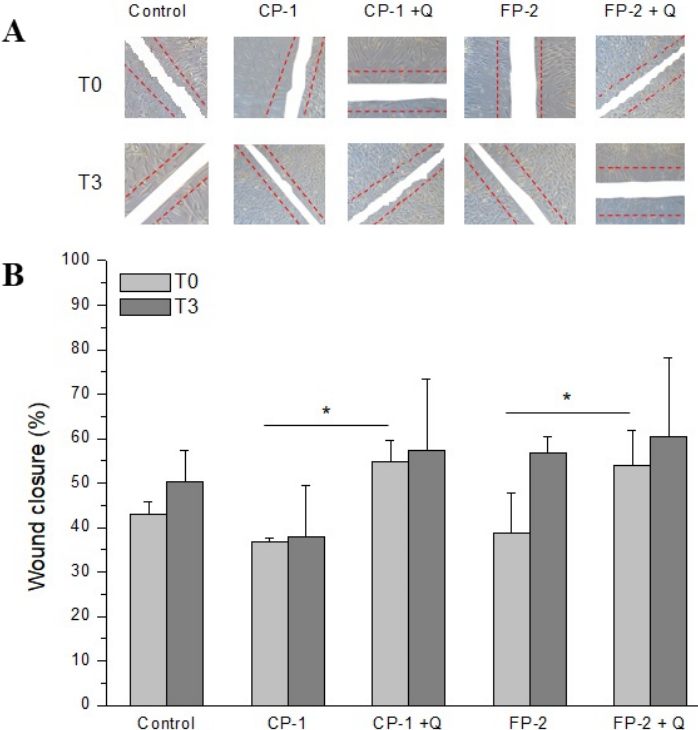
Figure 3. Percentage of fibroblast wound closure after 48 h treatment with supernatants derived from fresh not preserved HAM tissues (Control) or thawed HAM samples preserved with CP-1 or FP-2 in the presence (CP-1 + Q and FP-2 + Q) or not (CP-1 and FP-2) of quercetin. T0: supernatants collected after 40 min of HAM culture; T3: supernatants collected after 3 days of HAM culture. ( A ). Representative images used to evaluate the percentage of wound closure illustrated in ( B ). In the same figures, the initial wound (0 h) has been evidenced with dotted red lines while the wound after 48 h is indicated as a white area. The percentages of wound closure are represented as mean ± SD of 3 independent experiments. * p < 0.05 between the indicated bars.